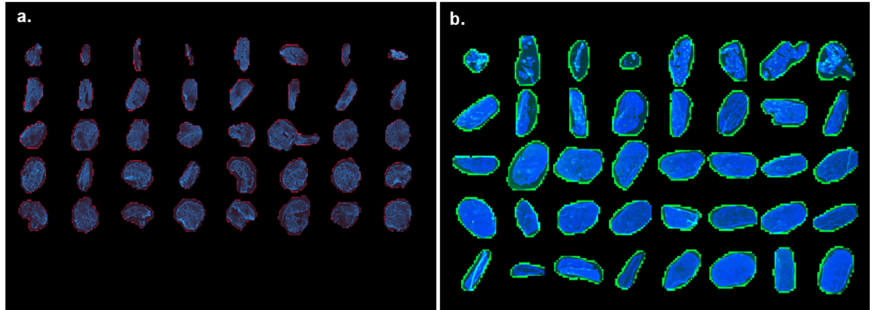
Figure 2. Background signals. ( a ) Cutaneous distribution of background Cy5 and ( b ) eGFP signals in untreated skin samples, i.e. in the absence of mRNA application. The images show background Cy5 (red), background eGFP (green) and DAPI (blue) signal at 24-h skin culture. (High resolution images of the above and all subsequent images) are available in the Supplementary Material: File S2 provides high resolution montages of all 40 skin sections for each skin